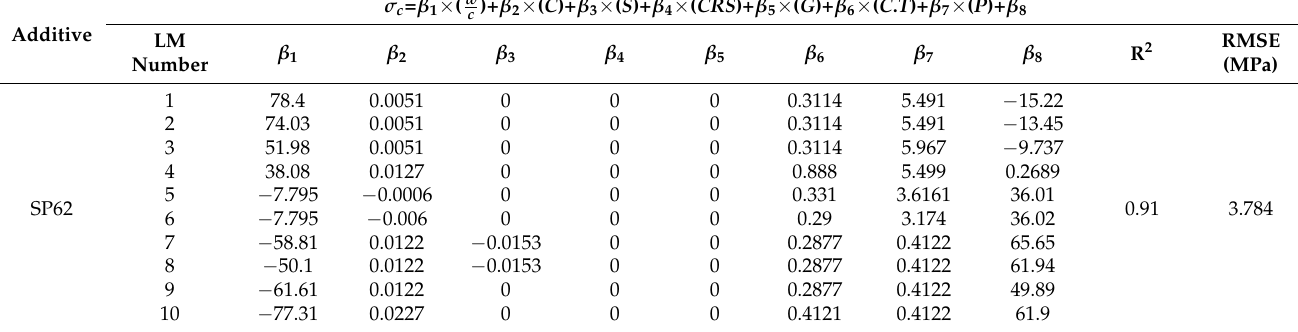
Table 6. M5P-tree model